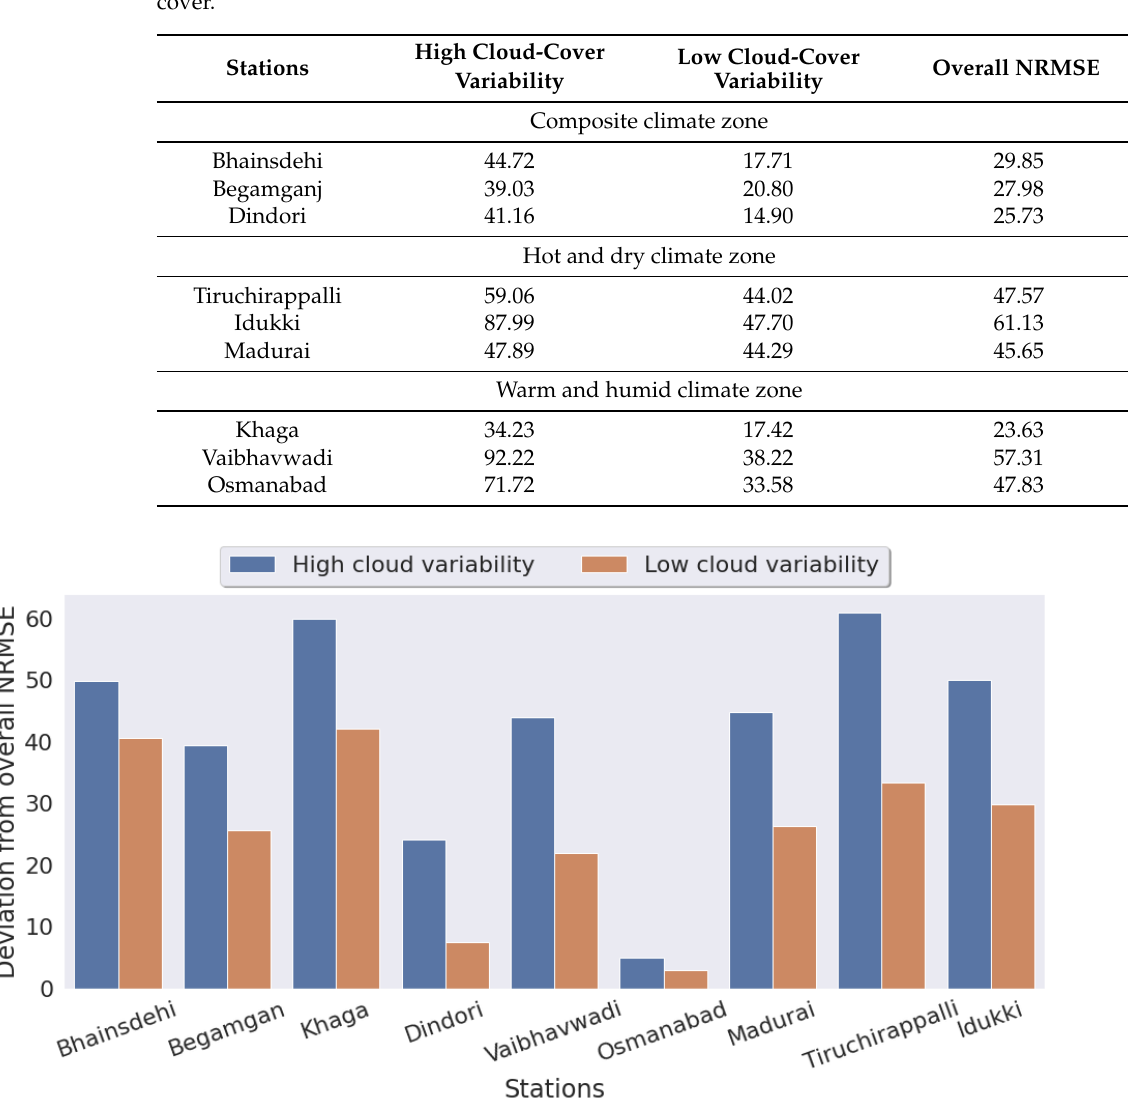
Table 1. Forecasting performance (NRMSE in %) of LSTM for high- and low-cloud-variability cloud cover.